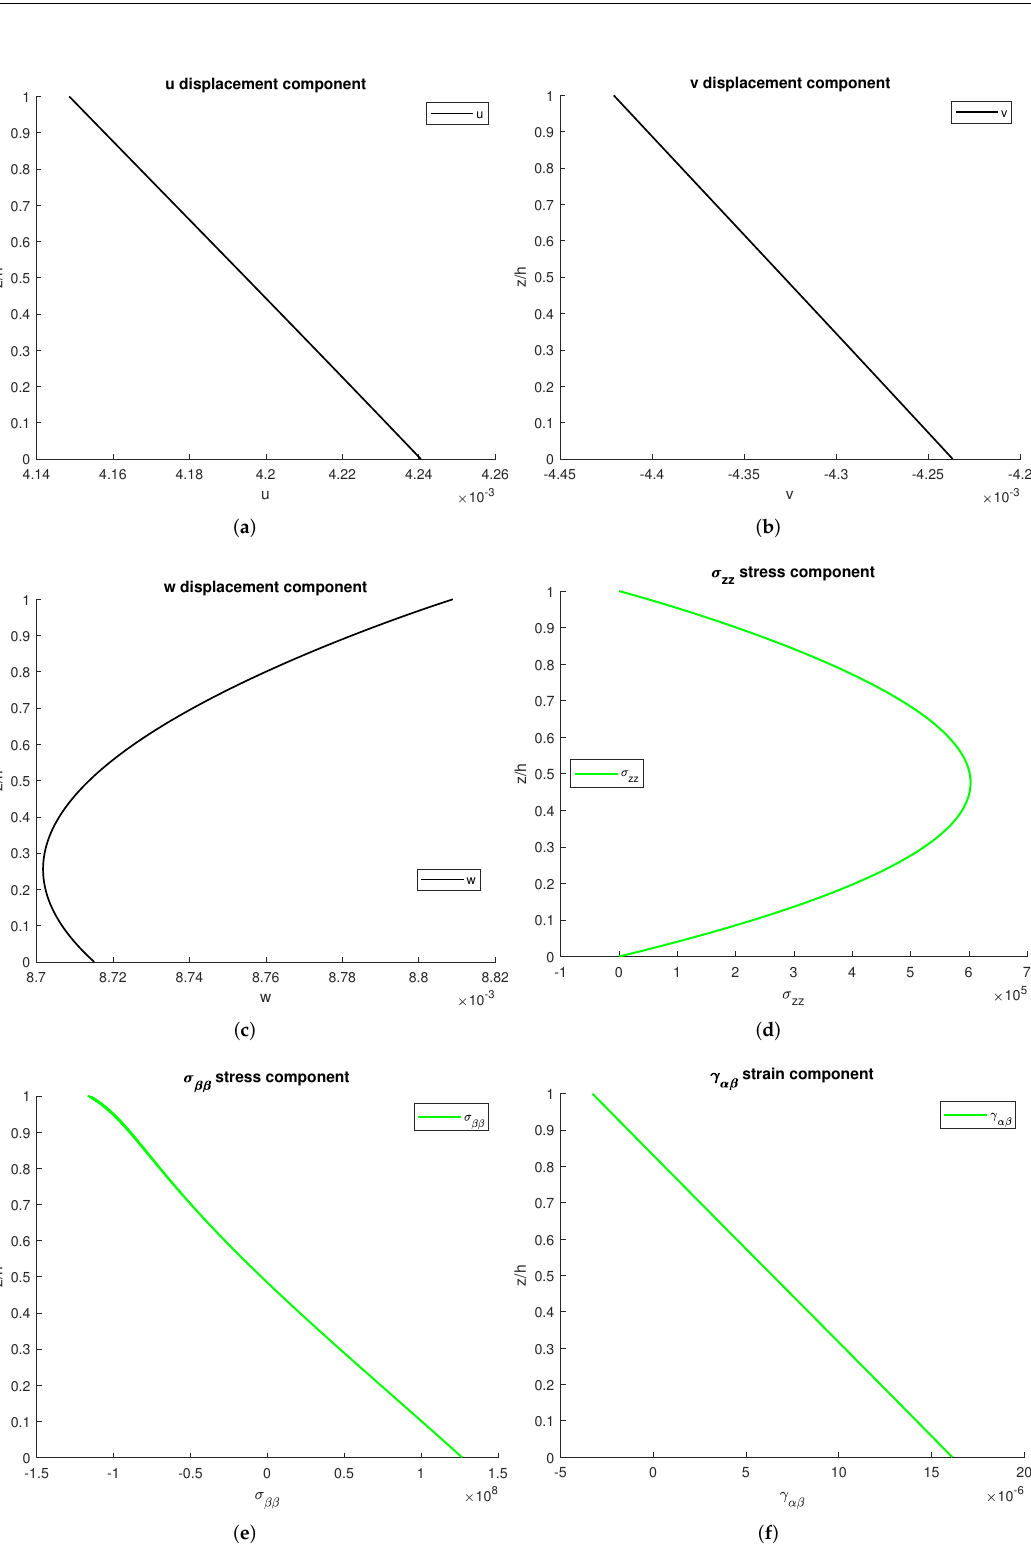
Figure 6. Second benchmark: one-layered FGM closed cylinder with an imposed moisture content on the top and bottom surfaces. The results are calculated for a moderately thin ( R α / h = 5) structure via the 3D( M c ,3 D ) model. ( a ) Amplitude of u displacement component. ( b ) Amplitude of v displacement component. ( c ) Amplitude of w displacement component. ( d ) Amplitude of σ zz stress component. ( e ) Amplitude of σ ββ stress component. ( f ) Amplitude of γ αβ strain